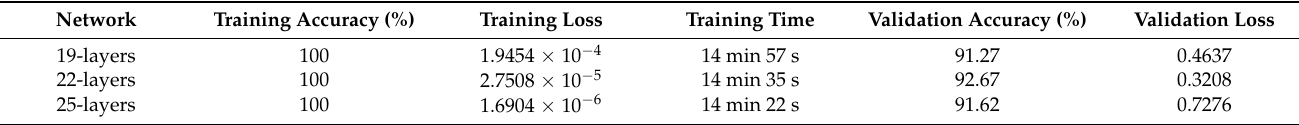
Table 4. Comparison of isolated-CNN models for four-class classification using dataset II.